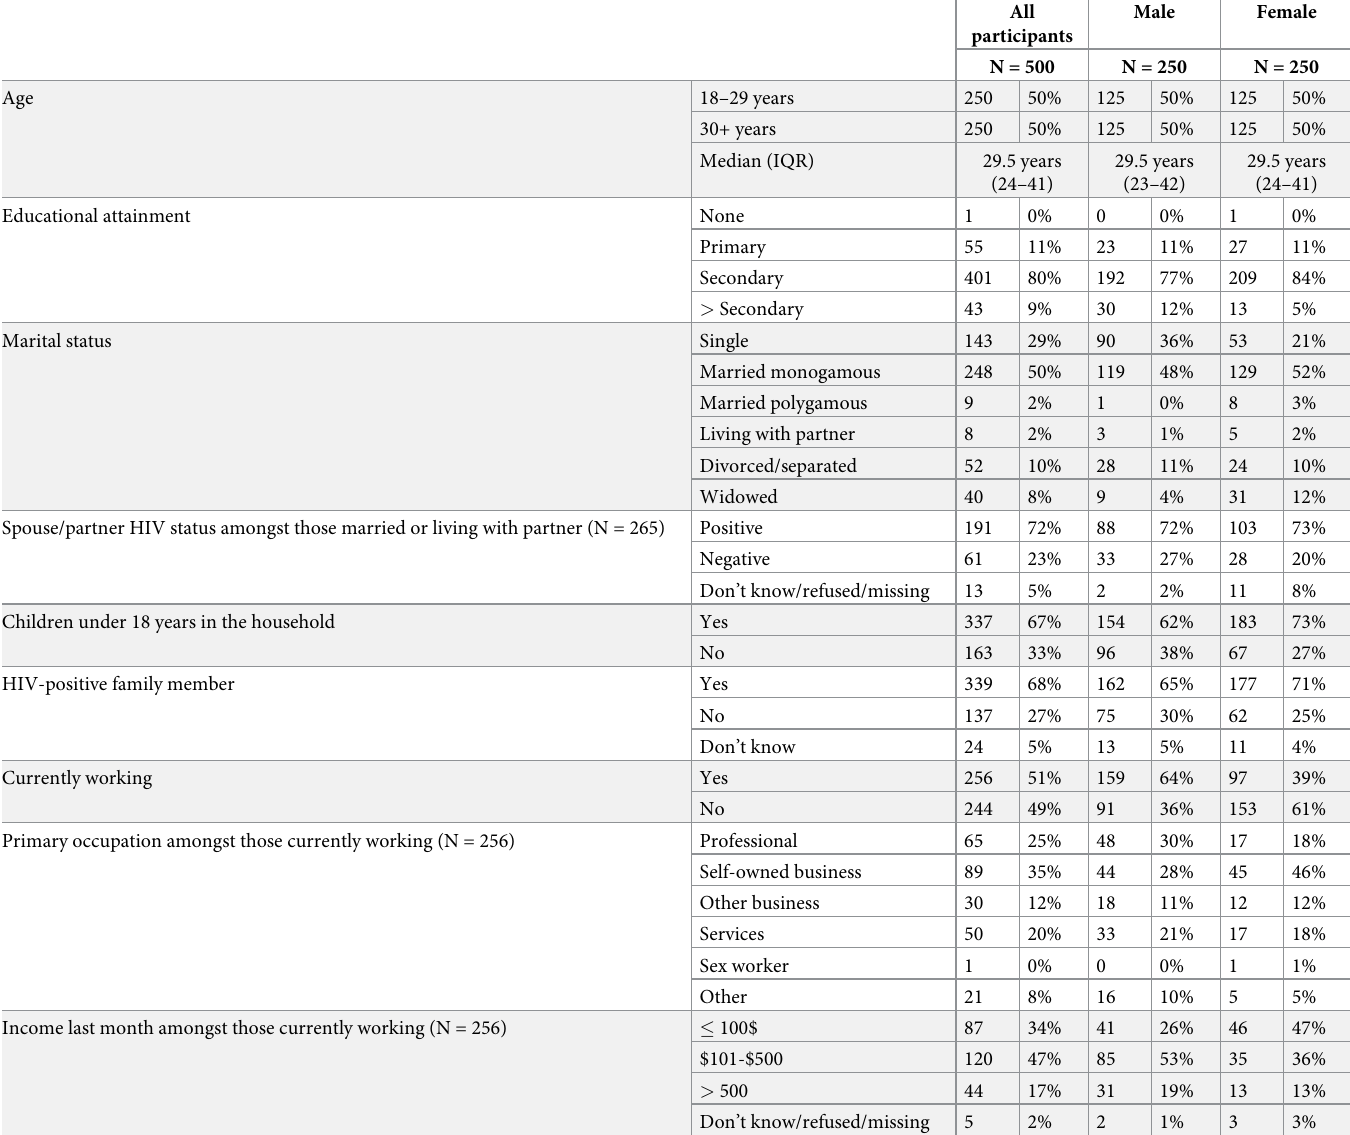
Table 2. Survey & DCE participant